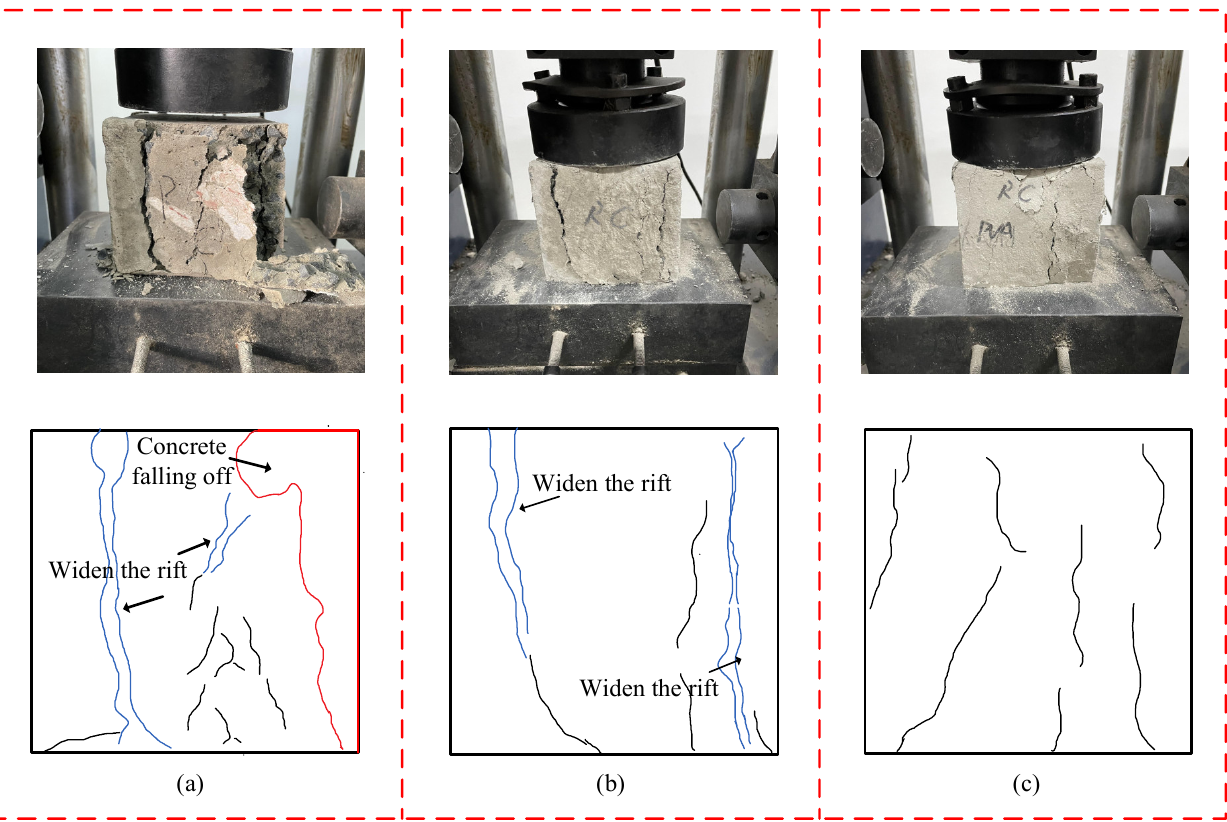
Figure 3. Compressive failure modes of concrete with different compositions: ( a ) Plain concrete; ( b ) Rubber concrete; ( c ) PVA rubber/concrete.